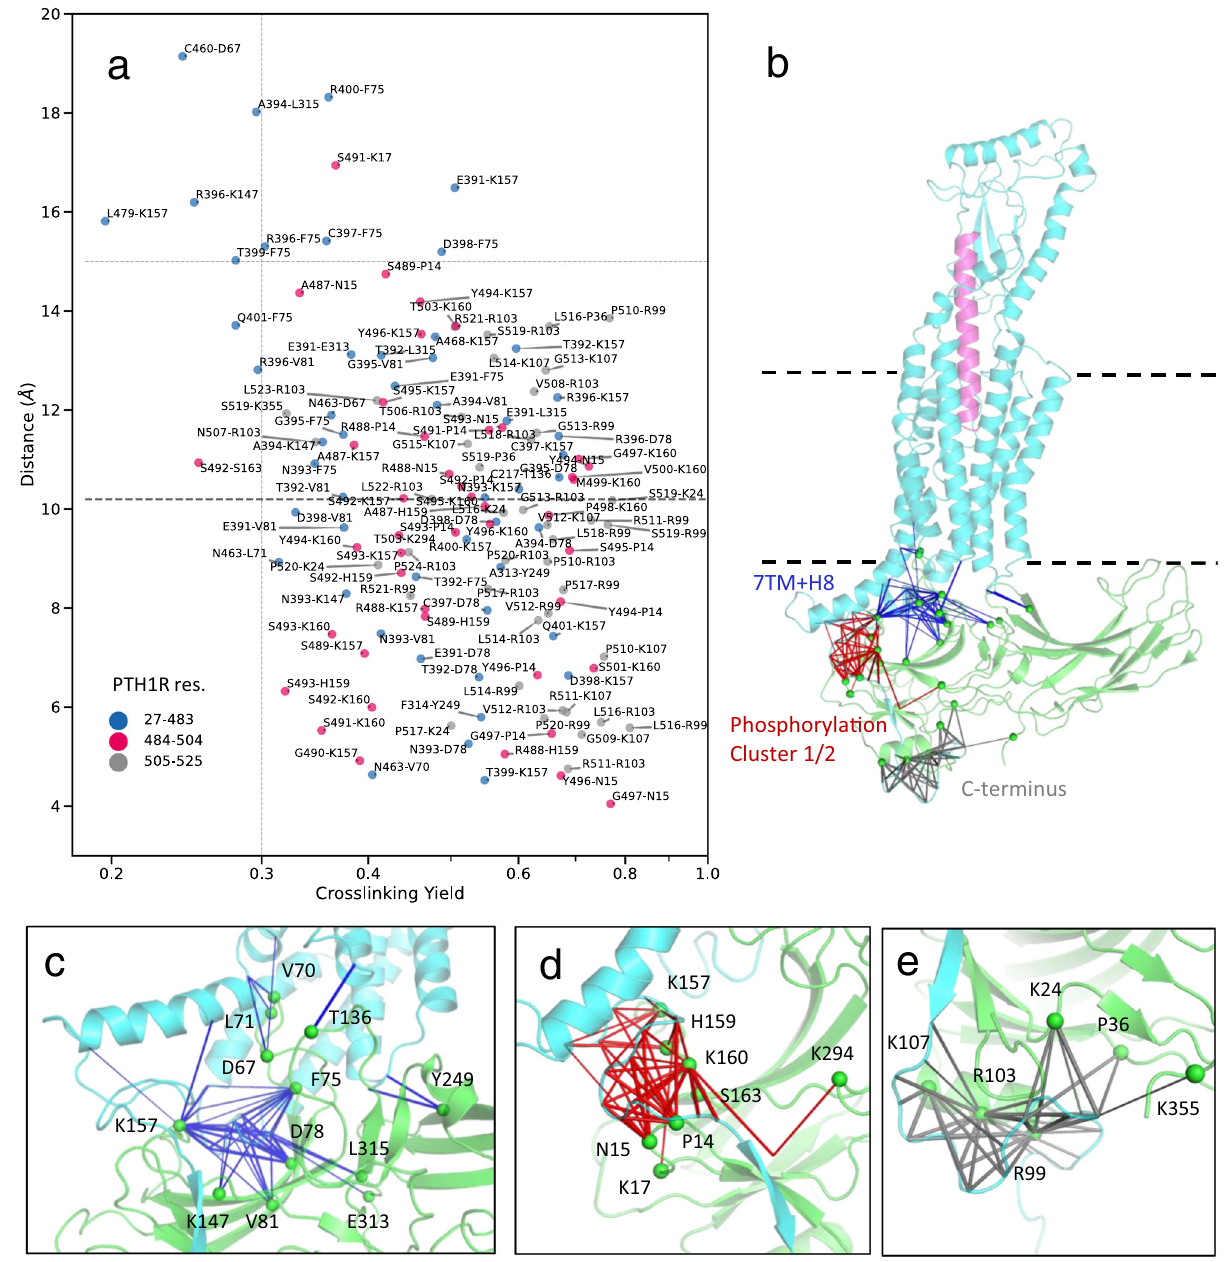
Fig. 3 | Crosslinking-guided model of PTHLA-PTH1R-arr2 complex. a Plot of pairwise C β -C β distances against chemical crosslinking yields in the PTH1R-arr2 model after fl exible re fi nement from the M 2 R-arr2 template. For glycine, C α was used instead of C β . The horizontal dashed line at 10.2Å marks the estimated dis- tance (C β -C β ) for BrEtY-Cys crosslinking, whereas the dotted line at 15.0Å repre- sents the maximal crosslinking distance when taking into account the fl exibility of the complex.The large majority of thecrosslinking pairs (125out of 136),lie within 15.0Å in the static 3D model, suggesting overall agreement with the crosslinking